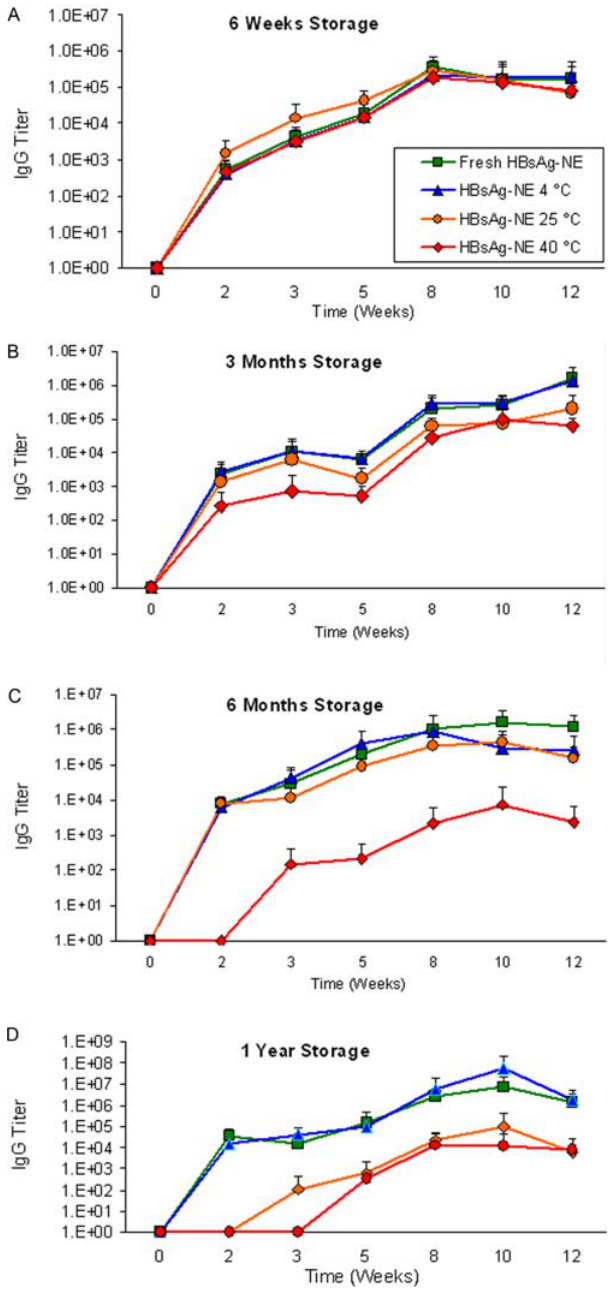
Figure 8. In vivo analyses of HBsAg-NE stability. HBsAg specific antibody responses to freshly prepared HBsAg-NE or HBsAg-NE stored under real-time (4 u C), accelerated (25 u C) and stressed (40 u C) temper- ature conditions are depicted. CD-1 mice were vaccinated with either freshly prepared or stored HBsAg-NE and boosted at 6 weeks. Serum anti-HBsAg IgG antibody concentrations are presented as a mean of endpoint titers in individual sera + / 2 SD. Comparison of serum IgG elicited by freshly prepared HBsAg-NE to formulation stored for (A) 6 weeks, (B) 3 months, (C) 6 months or (D) 1 year at indicated temperatures. * indicates a statistical difference ( p value , 0.05 ) in the anti-HBsAg IgG titers between freshly mixed and stored formulation. Arrows indicate vaccine